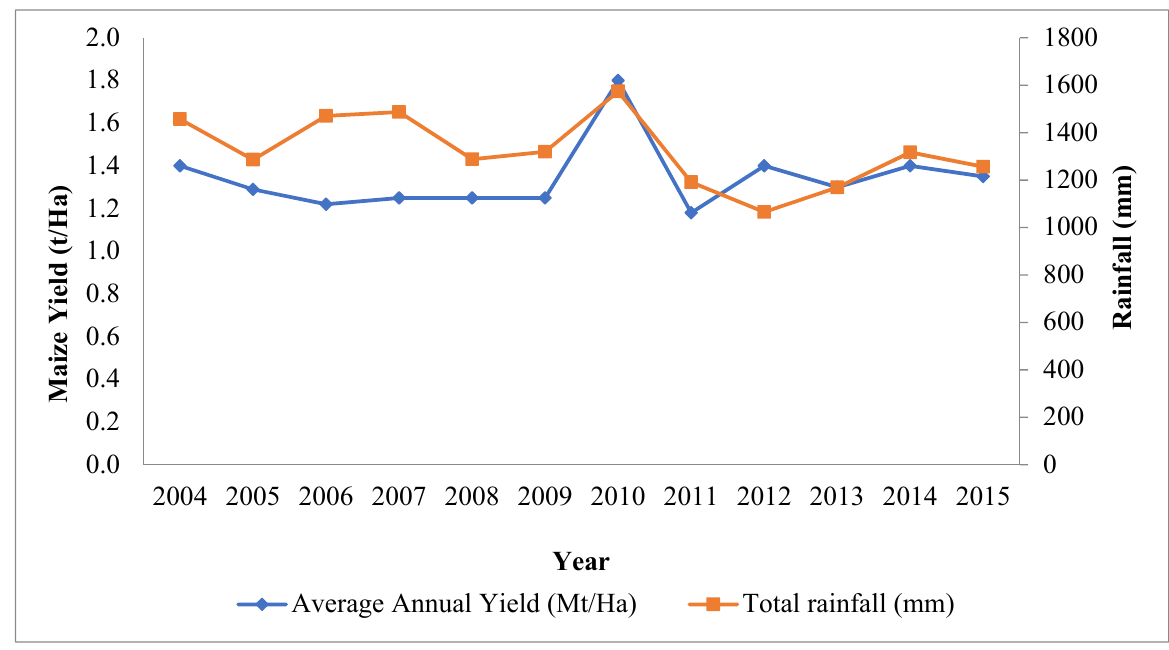
Figure 7. Relationship between annual rainfall (mm) and annual maize yield (t/Ha) .